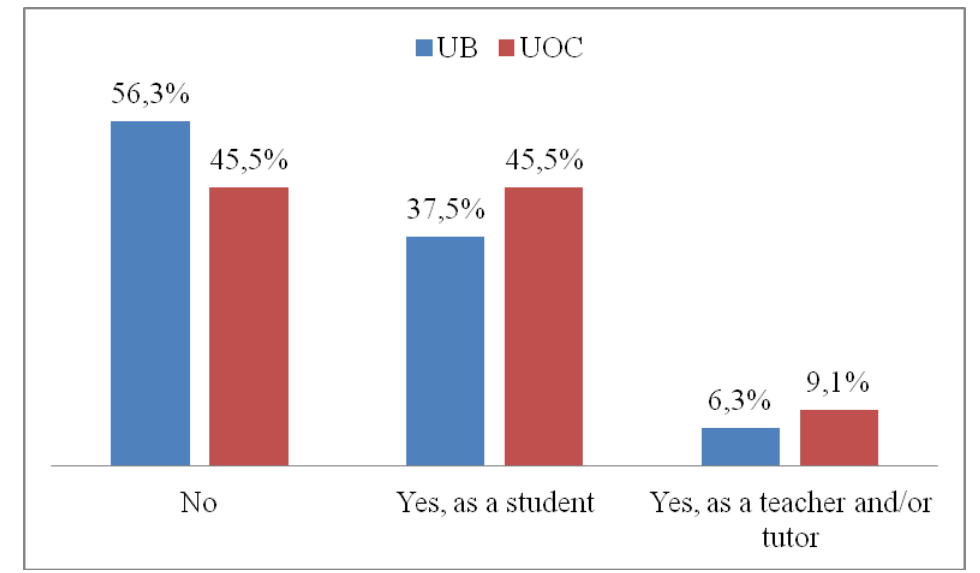
Figure 2. Comparison of participation by teachers from a traditional university and a virtual university in a MOOC.